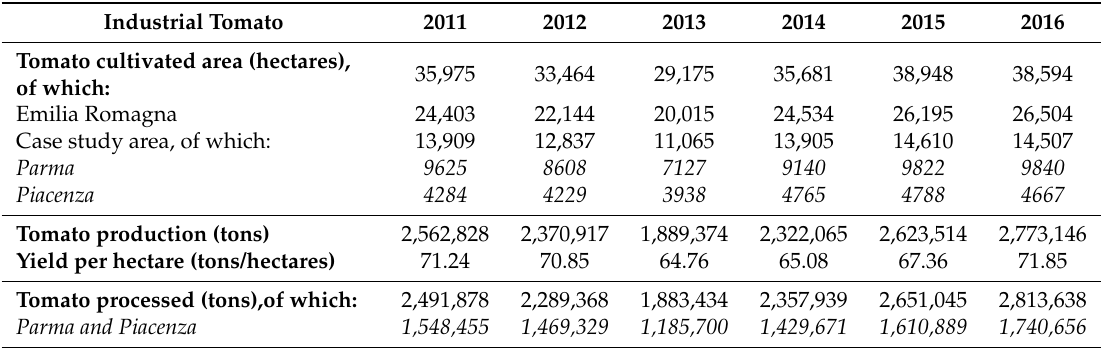
Table 2. Tomato production and processing in northern Italy (hectares,